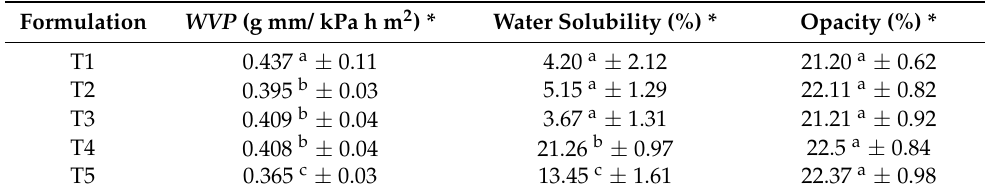
Table 2. Water vapor permeability, water solubility, and opacity properties of cassava starch/ gelatin films.